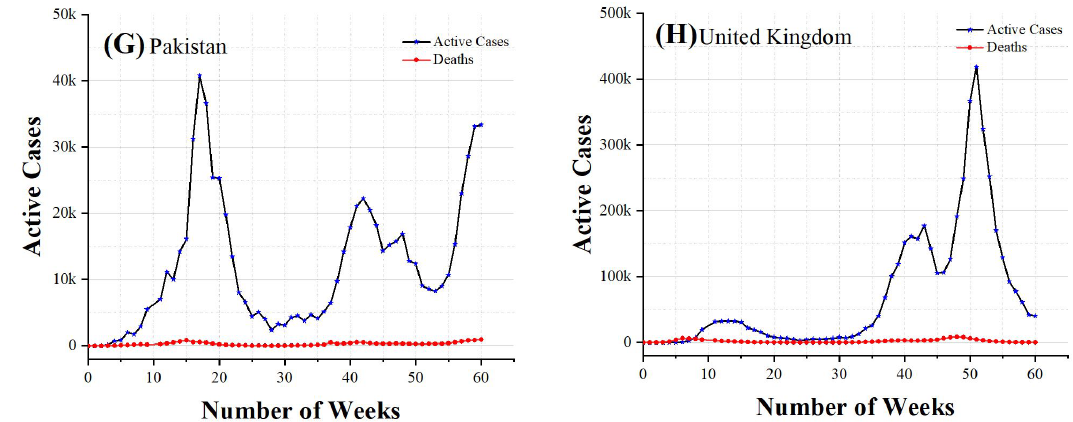
Figure 3. COVID-19 active cases and deaths in 60